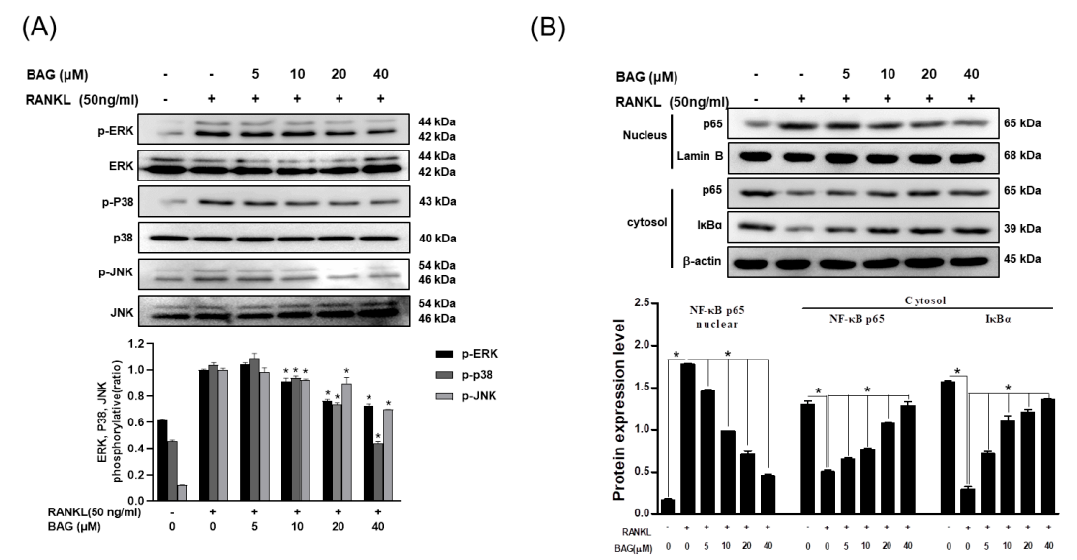
Figure 6. BAG suppresses RANKL-induced activation of NF-k β and MAPKs. ( A ) RAW264.7 cells (5 × 10 5 cell/mL) were seeded for 24 h, then pre-incubated with the indicated concentration of BAG for 1 h and stimulated with 50 ng/mL of RANKL for 30 min and were subjected to Western blot analyses using specific antibodies’ phosphorylated forms of ERK, p38, and JNK. ( B ) NE-PER (Nuclear and Cytoplasmic Extraction Reagents) kits were used for separation of cytoplasm and nucleus, and Western blot analysis was performed on each cytoplasm and nucleus. Graphs show normalized expression of each indicated protein against the expression of β -actin or lamin B. * p < 0.05 versus the RANKL-treated